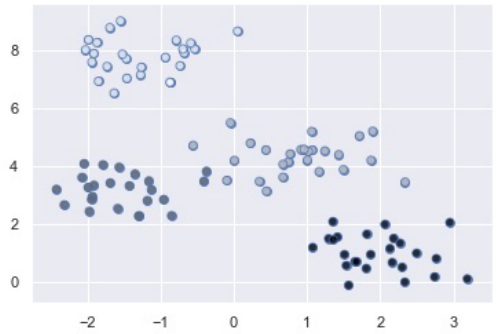
Figure 3. User clusters in a lower dimensional (2D)